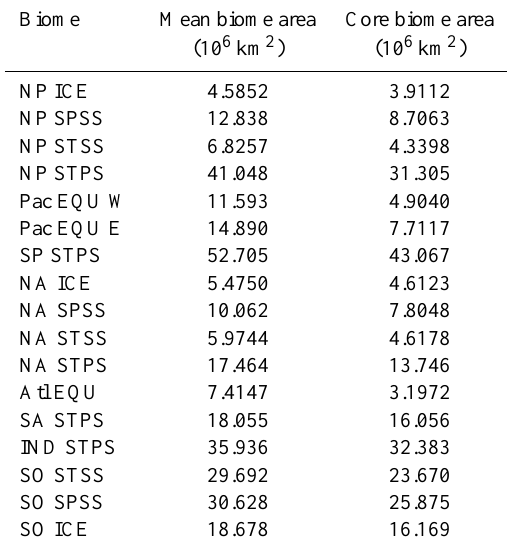
Table 2. Size (in 10 6 km 2 ) of the mean biomes and core biomes.